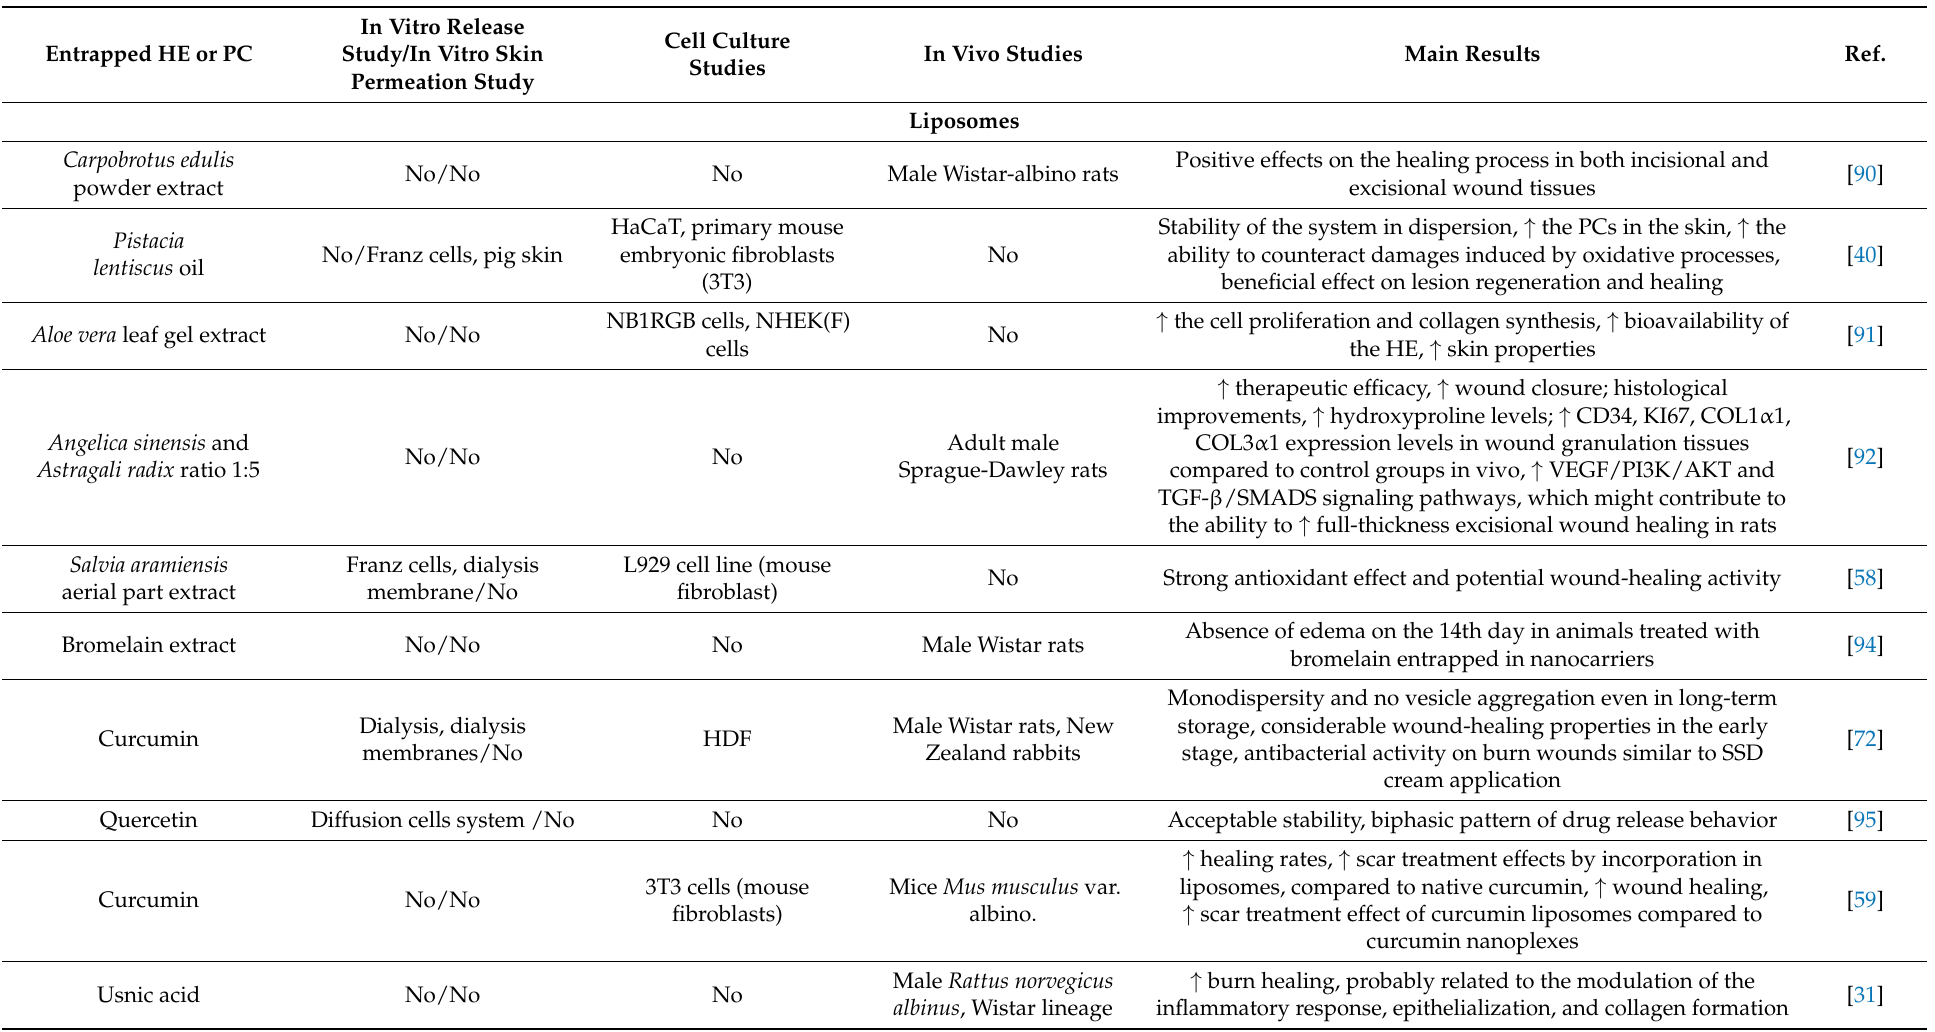
Table 5. In vitro and in vivo studies undertaken for vesicular nanosystems loaded with herbal extract or